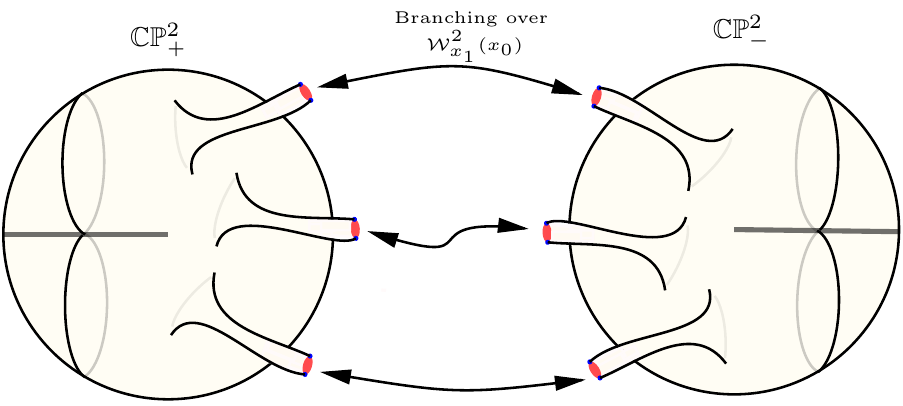
Figure 7 . Real section of a K3-surface as the double cover X of CP 2 , branched over the branch locus